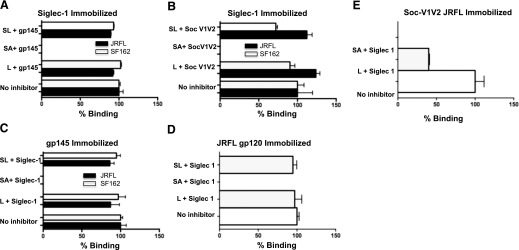
Sialic acid inhibits binding of monomeric and trimeric HIV-1 envelope proteins and V1V2 to Siglec-1.JR-FL FD trimeric gp145 and SF162 FD trimeric gp145 (50 nM) proteins (A) or Soc-V1V2JR-FL and Soc-V1V2SF162 (100 nM) (B) were incubated in the absence or presence of 6′-sialyllactose (SL, 1 mM), SA (SA, 10 mM), or lactose (L, 10 mM) and were then injected over immobilized Siglec-1 (3700 RUs). In separate experiments, Siglec-1 (50 nM) was incubated in the absence or presence of 6′-sialyllactose (SL, 10 mM), SA (SA, 10 mM), or lactose (L, 10 mM) and then injected over immobilized JR-FL FD trimeric gp145 (1400 RUs) or SF162 FD trimeric gp145 (900 RU) (C) or JR-FL gp120 (D) or Soc-V1V2JR-FL (E). The data are represented as bar graphs and show the percentage binding (means ± sd) of triplicate measurements as determined by SPR analysis.